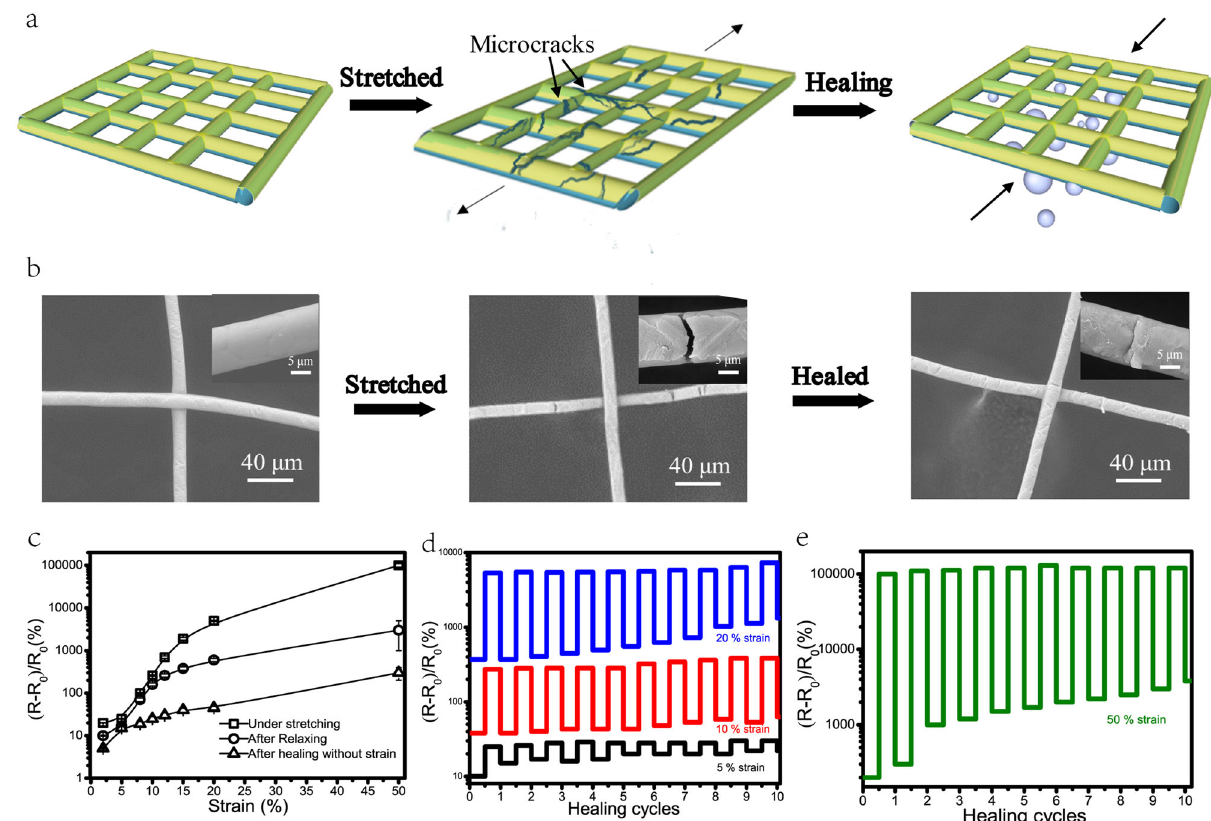
Fig. 2 a Representation of the treatments used for healing the Au network electrode. b SEM images for original, damaged and healed surface of Au micro fi ber (from left to right). c Change of the resistance of the Au network under stretching, after relaxing, and after healing without strain. d , e Resistance changes of the Au network for 10 stretching and healing cycles at 5, 10, 20, and 50%